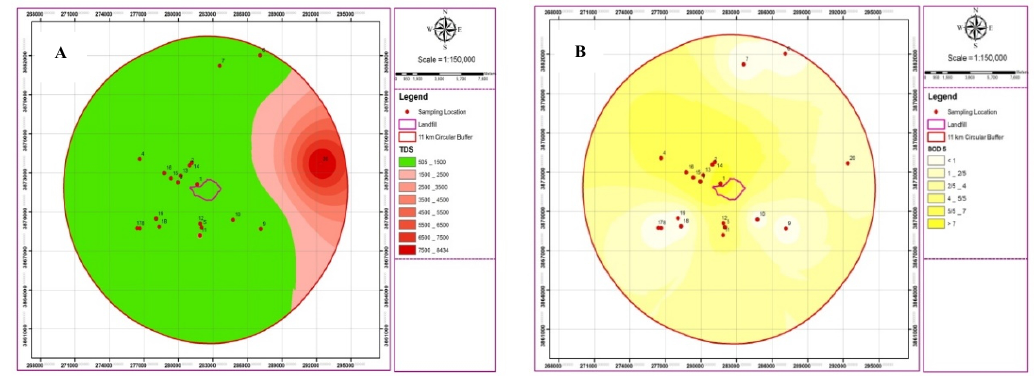
Fig. 3. Spatial Variation of (A) TDS, (B) BOD 5 in groundwater resources in the study